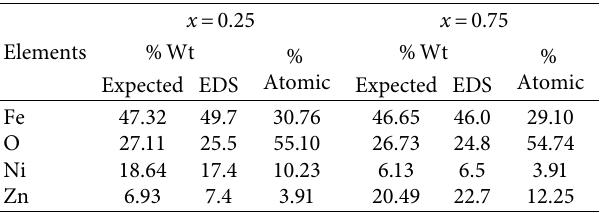
� 0.25 and (b) 0.75 annealed at 750 ° C. 1-x Zn x Fe 2 O 4 (a) x Table 6: Elemental composition of Ni 1-x Zn x Fe 2 O 4 nanoparticles annealed at 750 °